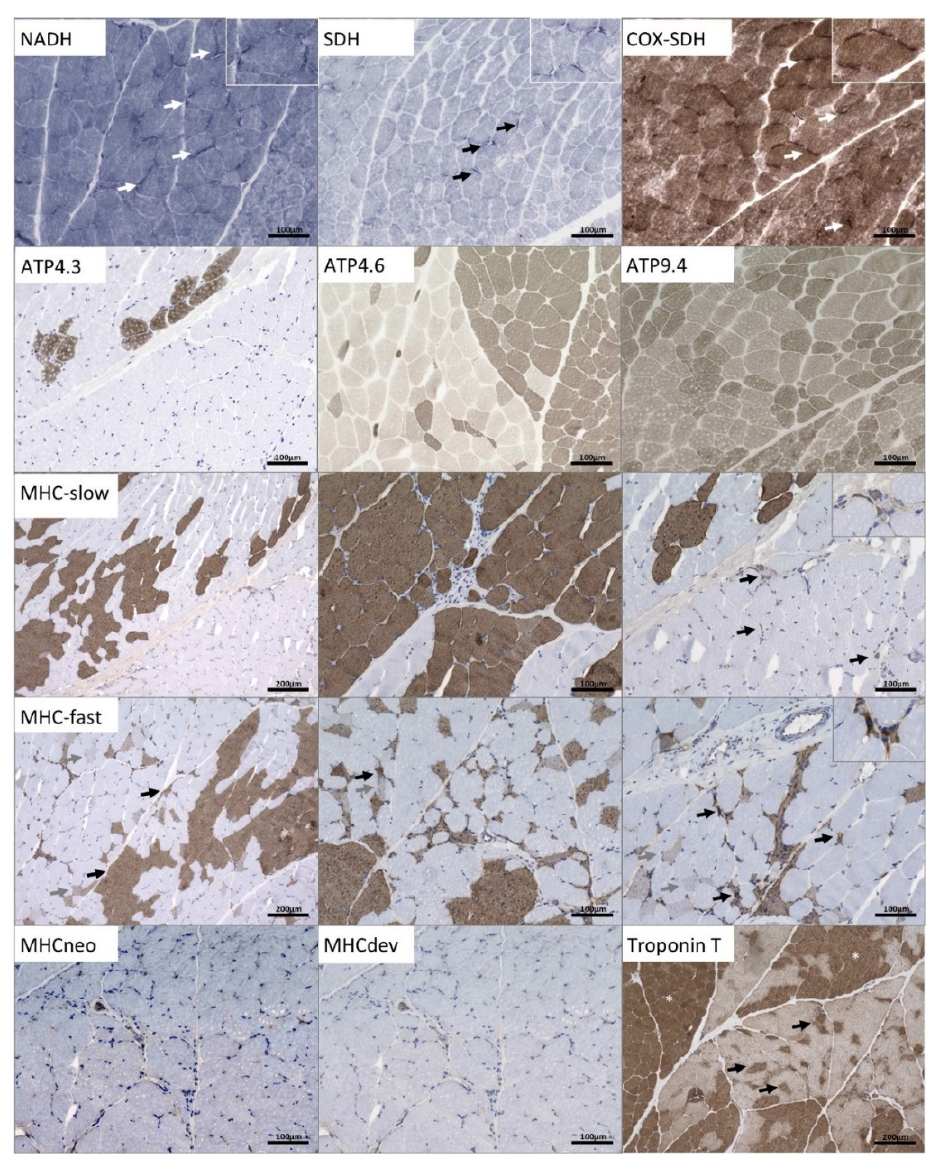
Figure 3. Light microscopic (histology and immunohistology) findings in a quadricep muscle biopsy derived from the p.(A20S)-SPTLC1-patient: Enzyme histochemical NADH-TR, SDH, and COX-SDH preparations indicating mild subsarcolemmal accumulation of substrate in single fibers (arrows). Grouping and atrophy of fibers of either fiber types are highlighted with ATPase preparations incubated at different pH levels, like the immunohistochemical MHC fast and –slow stains